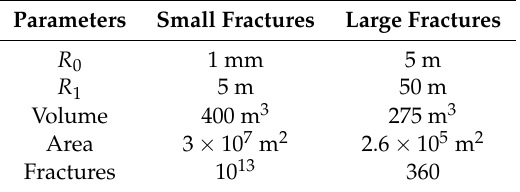
Figure 12. ( a ) Total amount of injected water in single frac stage is ∼ 750 m 3 . We assume that the water is retained in the SRV, which has the tip-to-tip width of 180 m, fracture height of 30 m, and fracture half-length of 50 m. The x -axis is the volume of injected water retained in the large discrete fracture network and the y -axis is the created surface area. The volume of proppant injected during each hydrofracture stage creates equal volume of discrete fractures, thus an average 40% (275 m 3 ) of the injected water goes into large fractures. The surface area created by this injected water volume is 2.7 × 10 5 m 2 , requiring fracture spacing of 2–4 m in the SRV. This spacing is the characteristic distance for the branching, complex fracture network. ( b ) Hydrofracture frequencies inferred from the information contained in the paper on the Eagle Ford Connoco Phillips pilot by Raterman et al. [64]. The dotted horizontal lines represent the range of effective fracture spacing postulated by the authors of [1,2,56]. Table 2. Comparison between small and large fracture